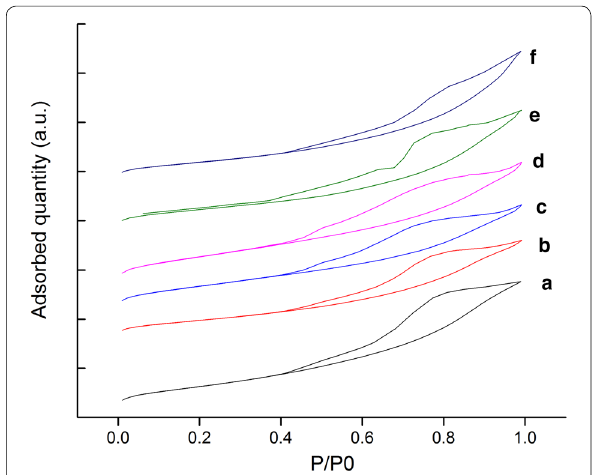
Fig. 1 BET isotherms for the prepared catalysts: (a) MgO/γ-Al 2 O 3 ; (b) 0.5 Zn/Mg; (c) 1 Zn/Mg; (d) 1.5 Zn/Mg; (e) 2 Zn/Mg and (f) ZnO/γ-Al 2 O 3